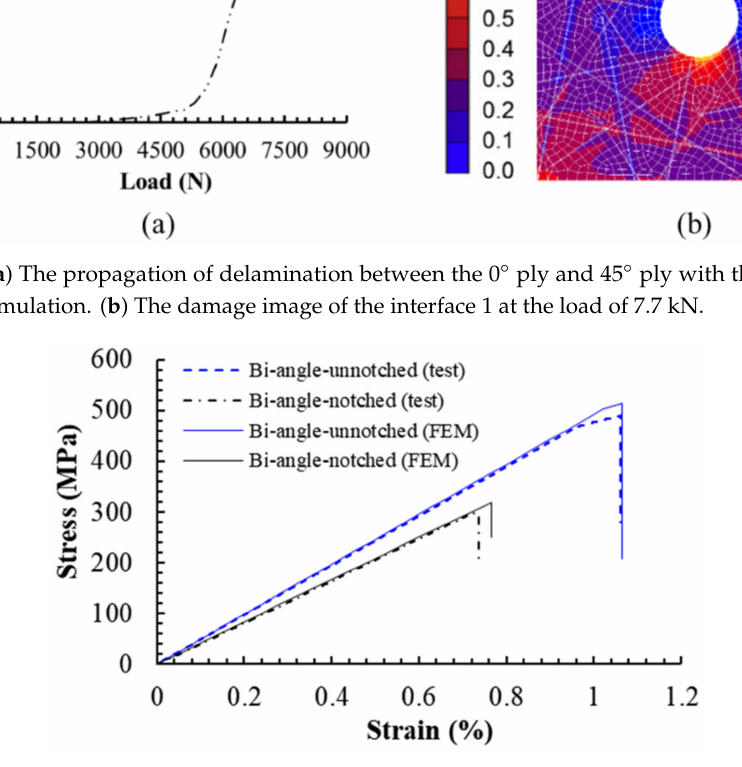
Figure 11. The typical stress-strain curve for the notched and unnotched UACS laminates with bi-angled slits obtained from numerical simulation and experiments.